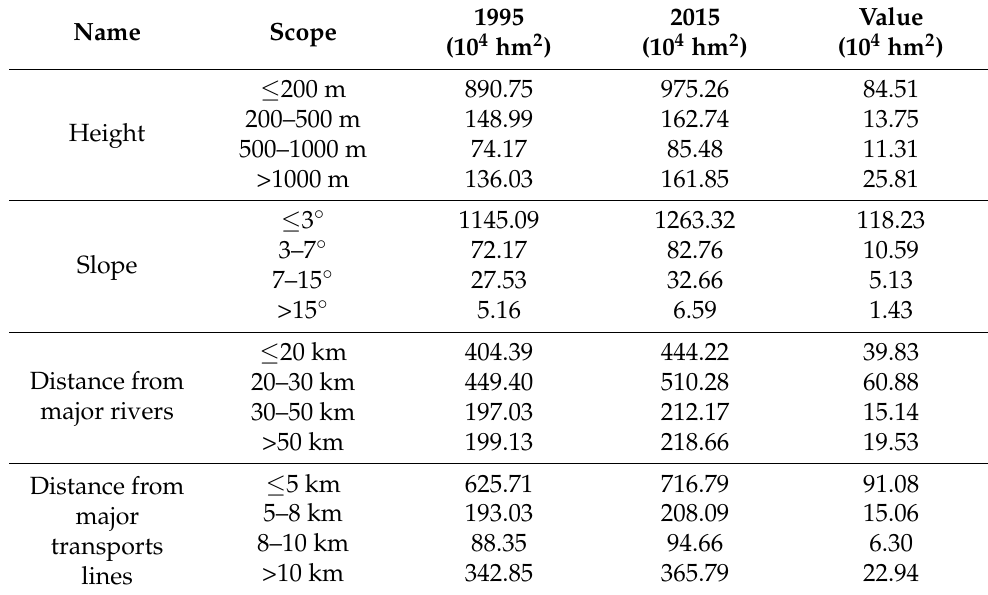
Table 1. Directional characteristics of rural settlement distribution changes in China 1995–2015.